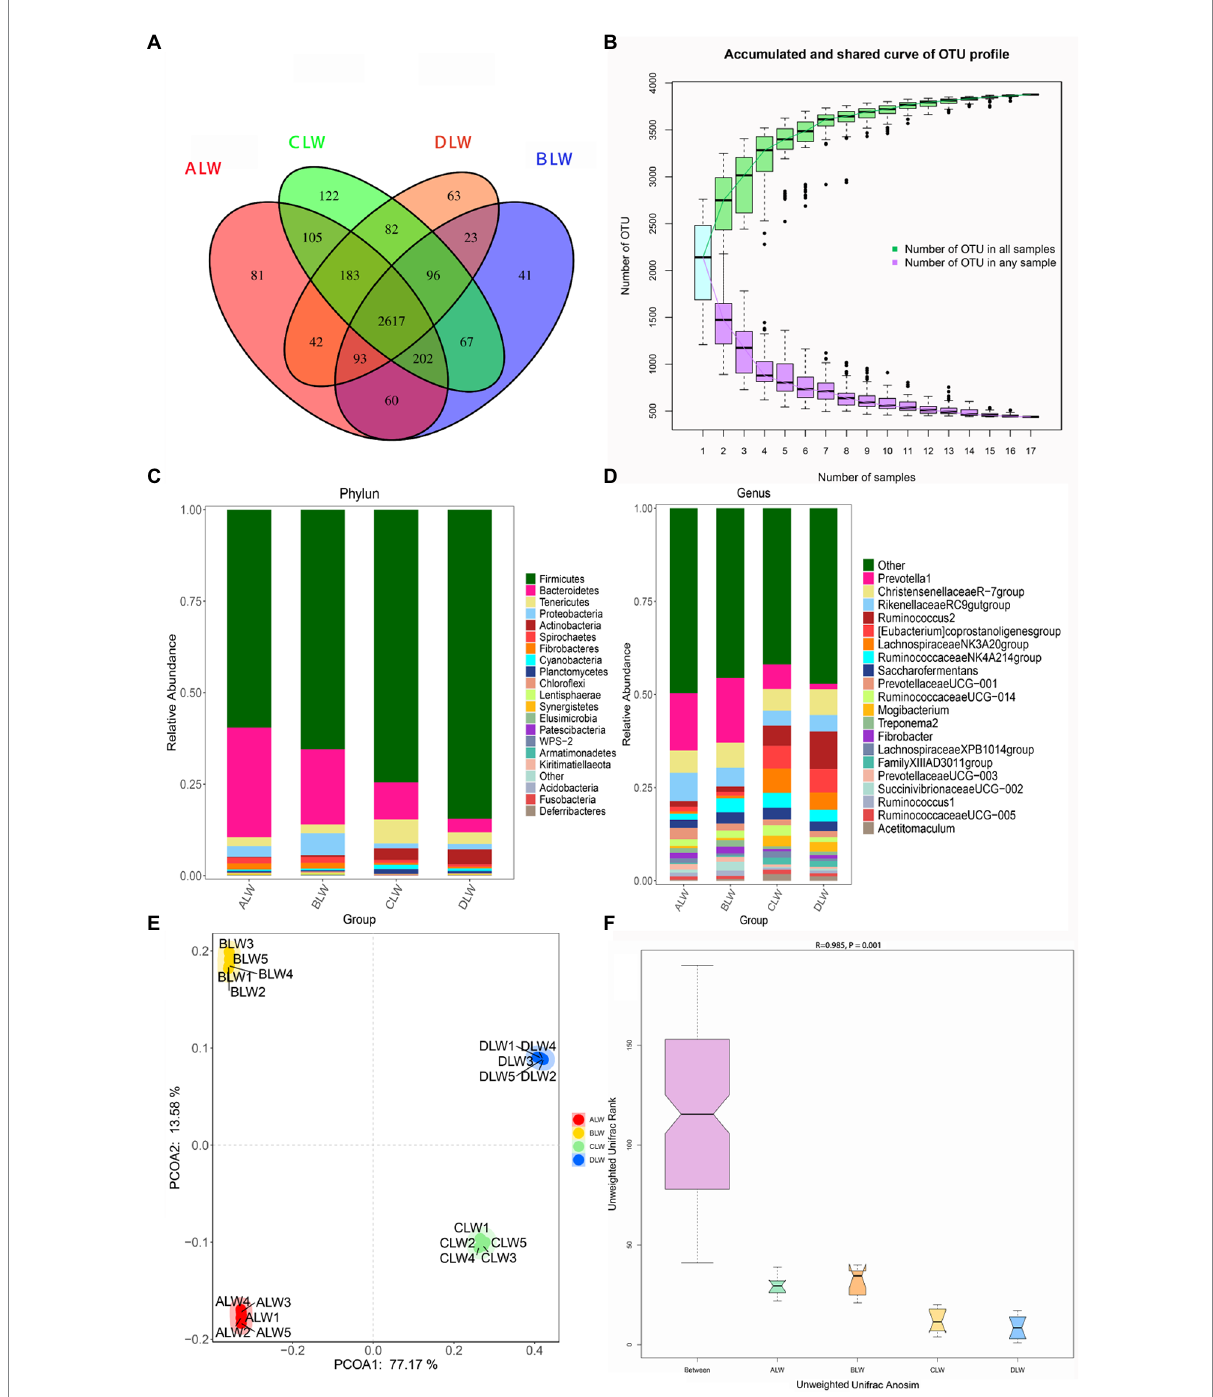
FIGURE 1 (A) OTU-Venn diagram (B) Species accumulation curves (C,D) Relative abundance of species at the phylum and genus level (E,F) PCoA and Anosim